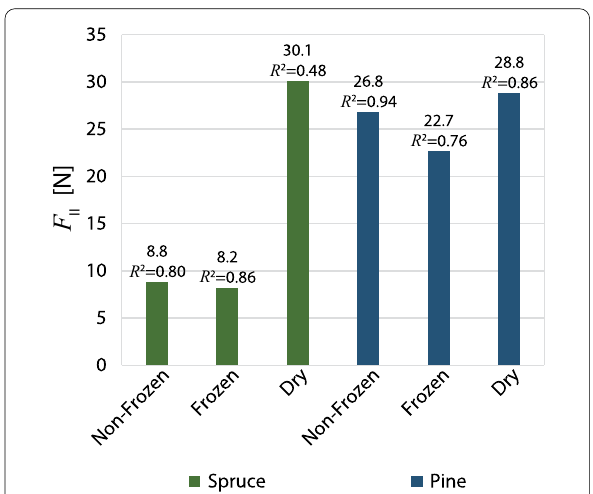
Fig. 9 The F II estimates (y-intercepts in the force–width plots) of the different cutting conditions and species. The R 2 value is indicated on top of the bar as well as the exact force value